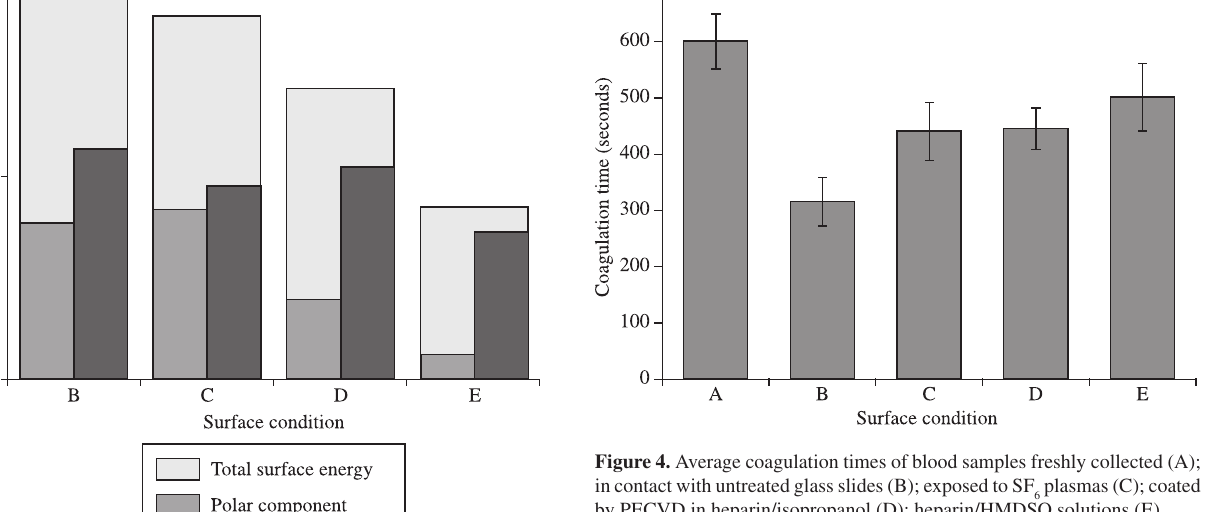
plasmas (C); coated 6